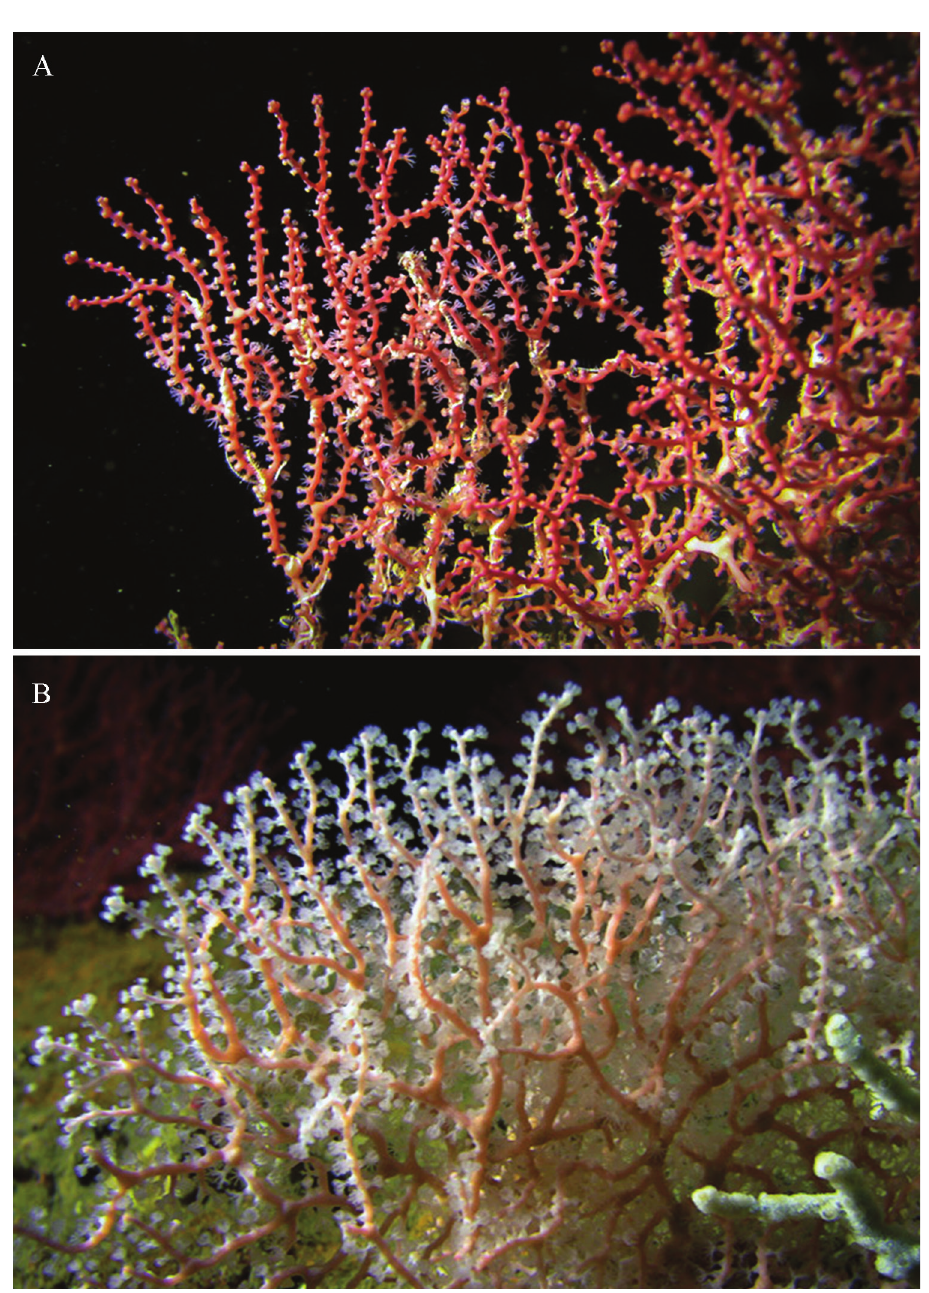
Figure 7. Underwater photographs of Melithaea davidi sp. n. at 79 m depth. A Holotype, RMNH Coel. 42122 B paratype, RMNH Coel.